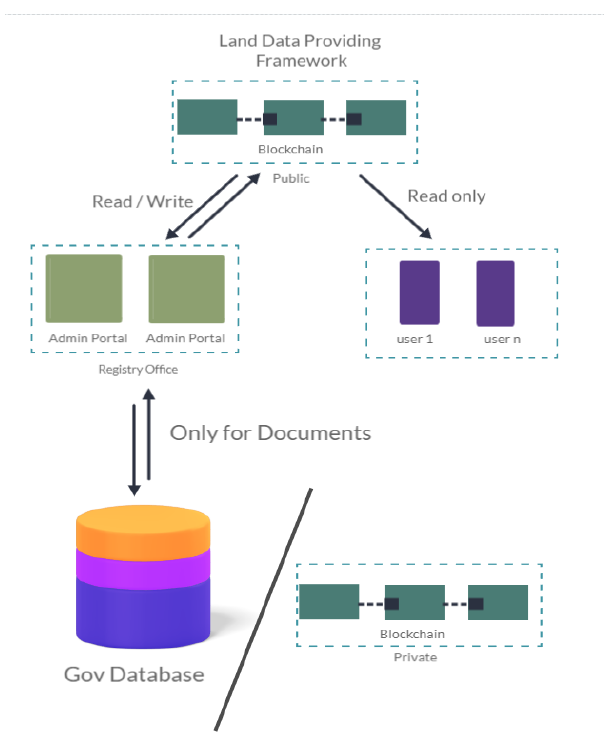
Fig. 1. Architecture Diagram of Proposed